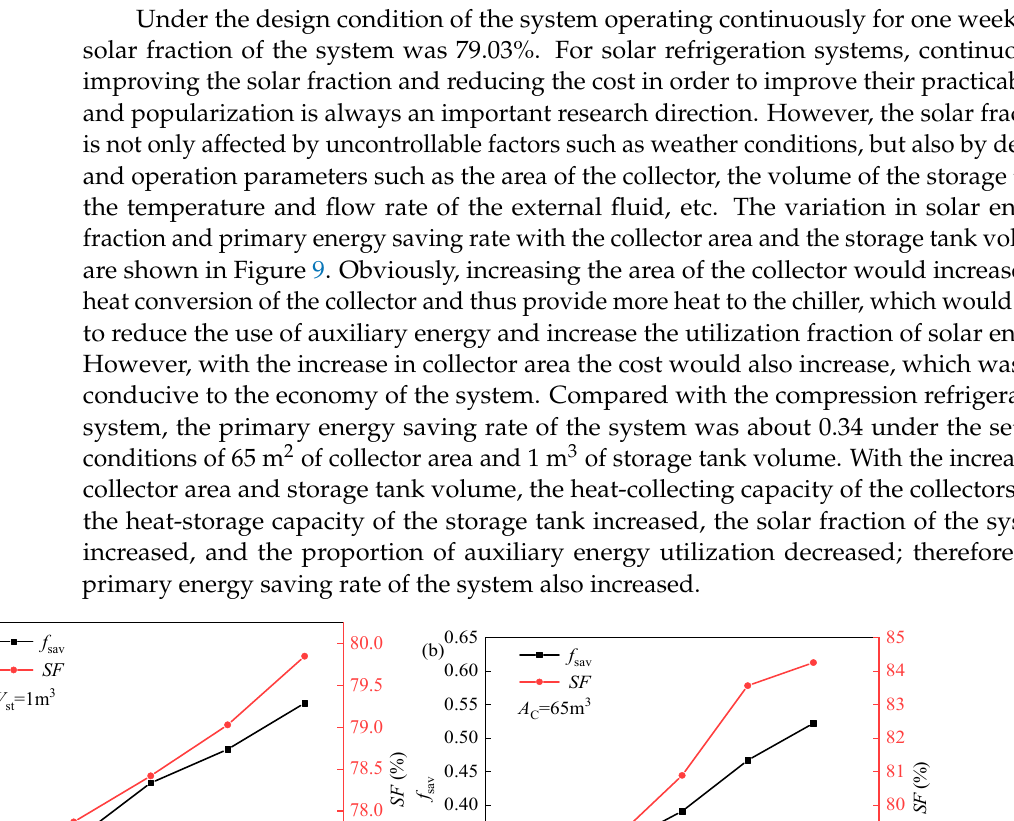
Figure 8. Accumulative cooling capacity, auxiliary heat source consumption, and heat stored in storage tank in a week of system operation.